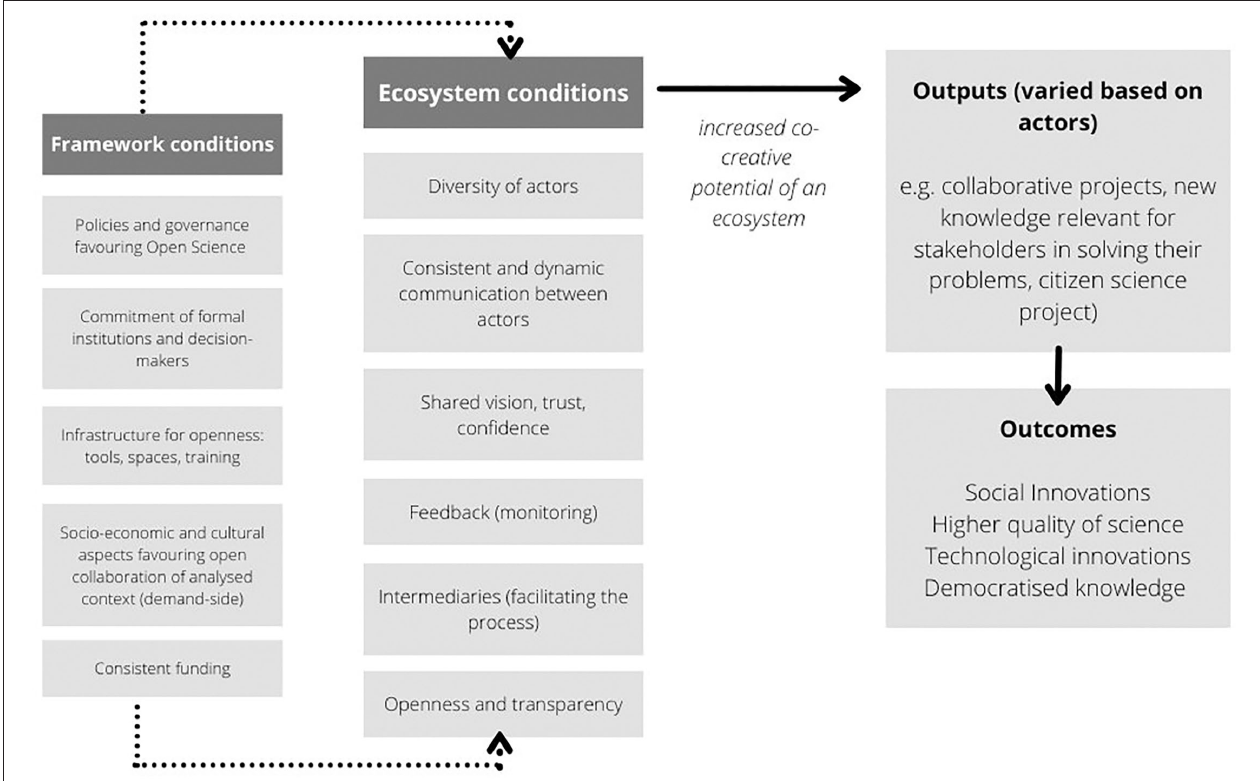
FIGURE 1 | Conceptual framework of open science ecosystem.